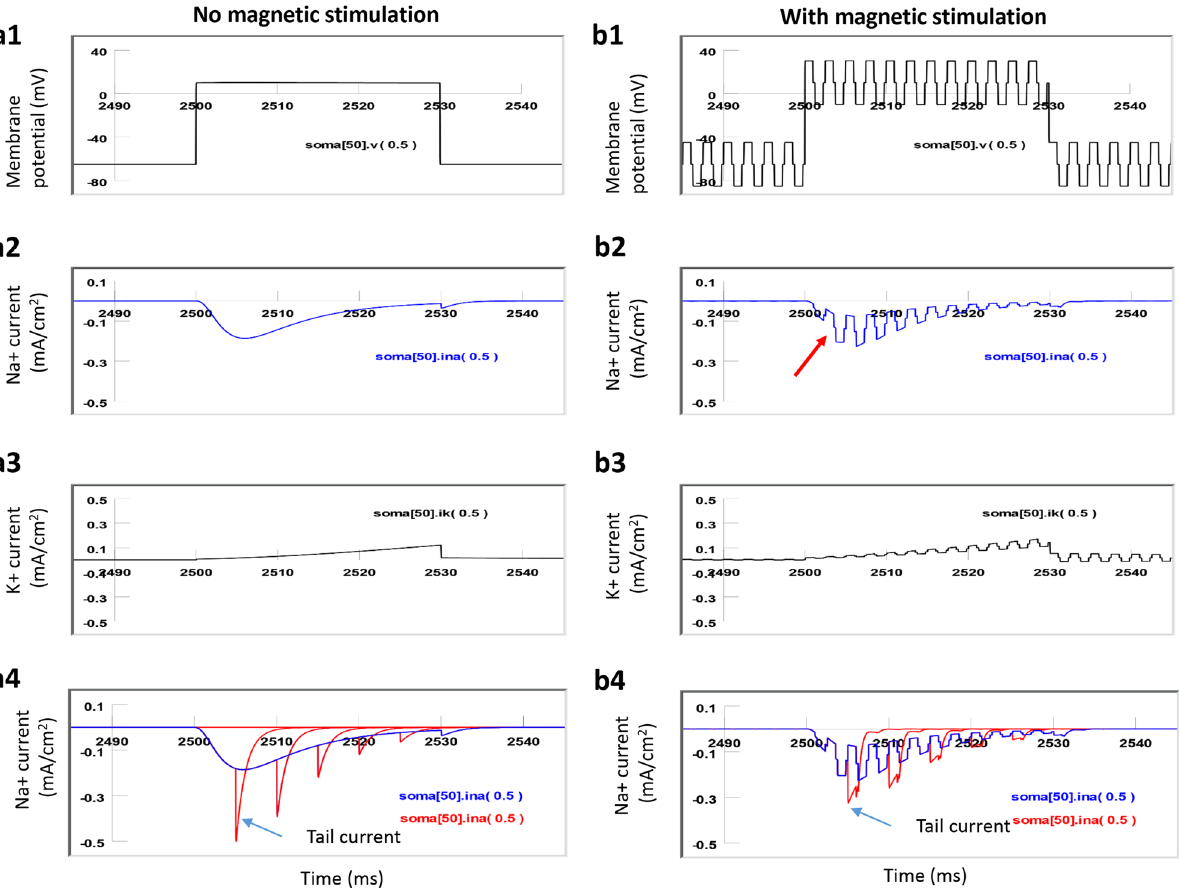
Figure 12. Sodium and potassium currents in a voltage clamp experiment (NEURON simulation). ( a1 ) Without magnetic stimulation, the membrane potential was clamped from − 65 to 10 mV for 30 ms. ( a2 ) Fast inward current (INa). ( a3 ) Slow outward (IK). ( a4 ) The sodium “tail currents” (red traces) were produced by varying the duration of clamping steps (from 5 to 30 ms, with 5 ms increments). The blue trace demonstrated the INa for a 30 ms clamping period. ( b1 ) With a 400 Hz magnetic stimulation, oscillation in the membrane potential occurred. ( b2 ) Fast inward current (INa). ( b3 ) Slow outward current (IK). ( b4 ) The amplitude of the sodium “tail currents” (red traces) was significantly decreased during magnetic